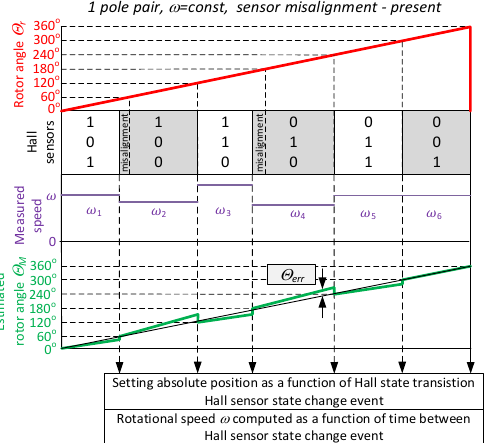
Setting absolute position as a function of Hall state transistion Hall sensor state change event Rotational speed w computed as a function of time between Hall sensor state change event Figure 3. Estimation of the angular position of the BLDC motor based on the change in the Hall sensors ’ state for the actual arrangement of the sensors.